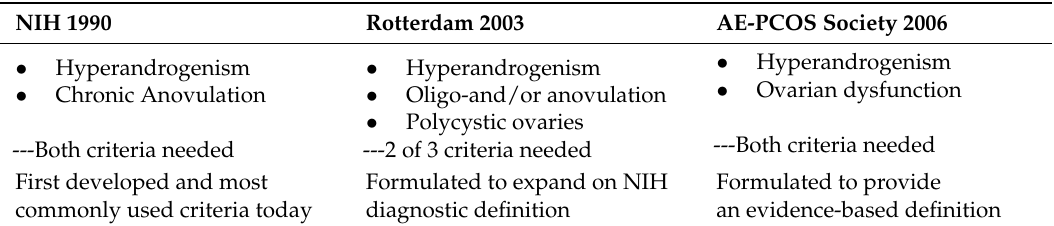
Table 1. Diagnostic criteria for